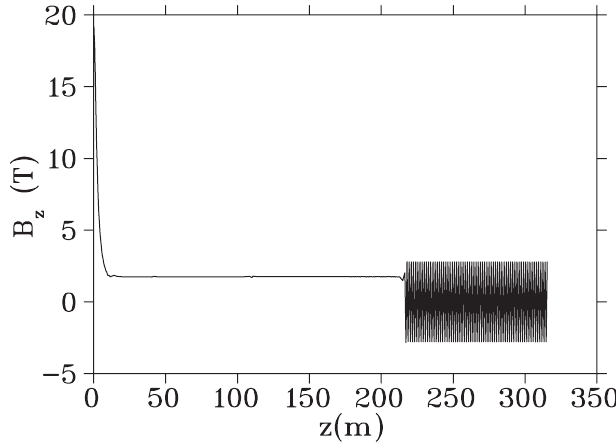
FIG. 7. (Color) Actual coil configuration in the collection re- on-axis along the z gion. The left axis shows the error field on-axis compared with the optimal capture field profile, denoted ST2B in Fig. 6.